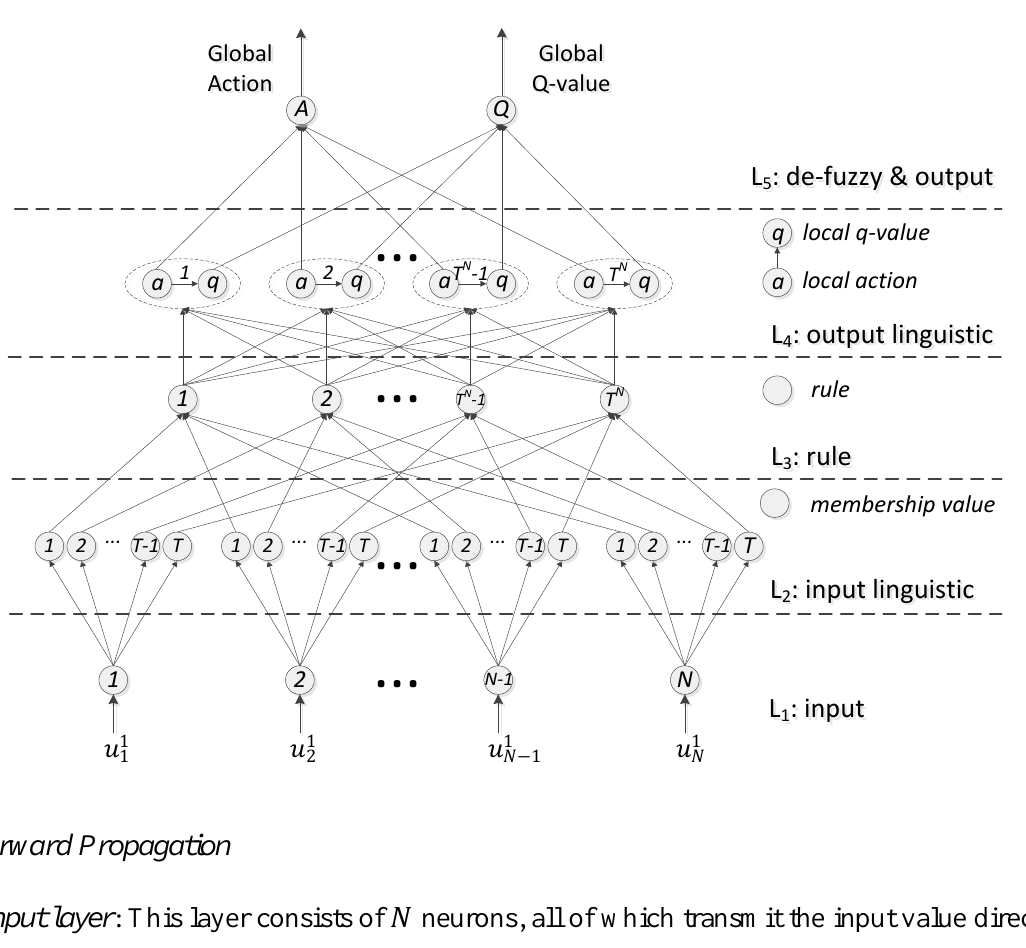
Figure 3. The topology of the reinforcement